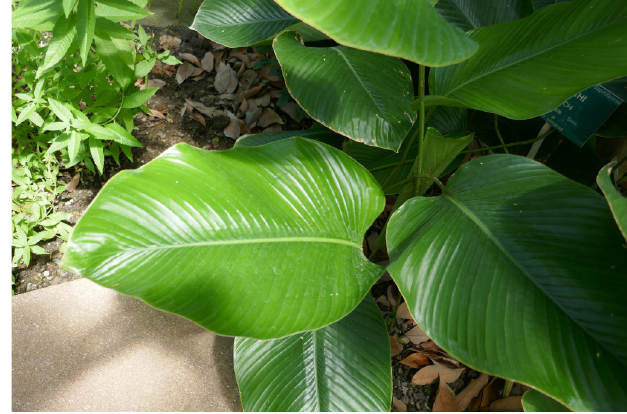
Fig. 4: Thaumatococcus daniellii (image by Ji-Elle, https://commons.wiki- media.org/wiki/File:Thaumatococcus_daniellii-Jardin_botanique_ Jean-Marie_Pelt_(3).jpg, CC BY SA